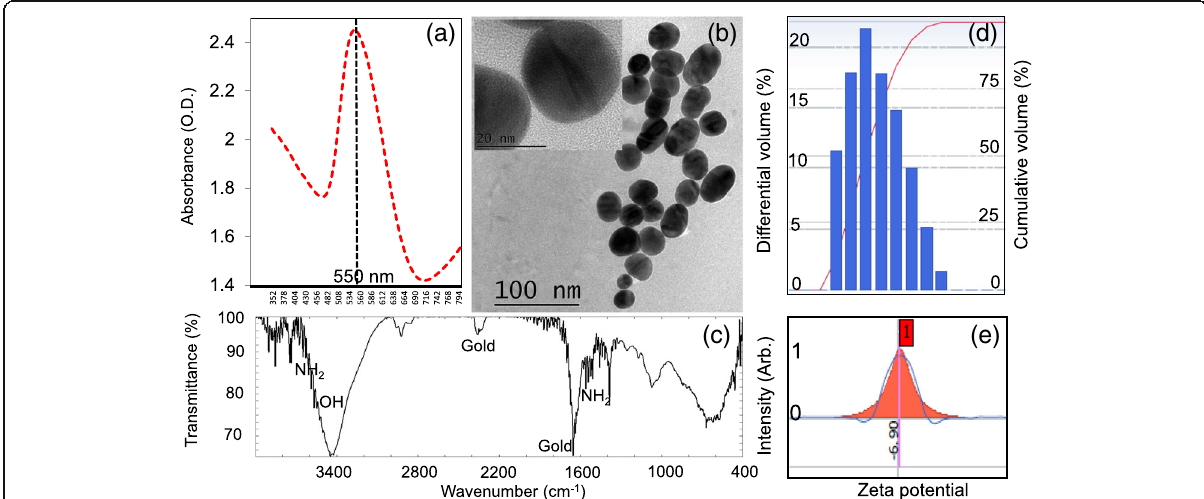
Fig. 2 Characterization of gold nanoparticles. Performed with the optimal size 15 nm. a UV-Vis spectrophotometry analysis. A prominent single peak was found at 550 nm. b Transmission electron microscope observation. Figure inset shows the enlarged image. Scale bar is shown. c Fourier-transform infrared spectroscopy analysis. Apparent peak positions for gold and NH 2 are indicated. d Volume distribution analysis of GNP. The obtained distribution is shown. e Zeta potential analysis. The value was found to be −